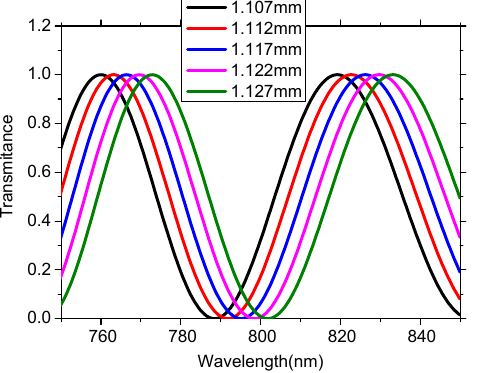
Figure 2. The transmittance spectra of a 1.117 mm thickness WP for different rotation angles.